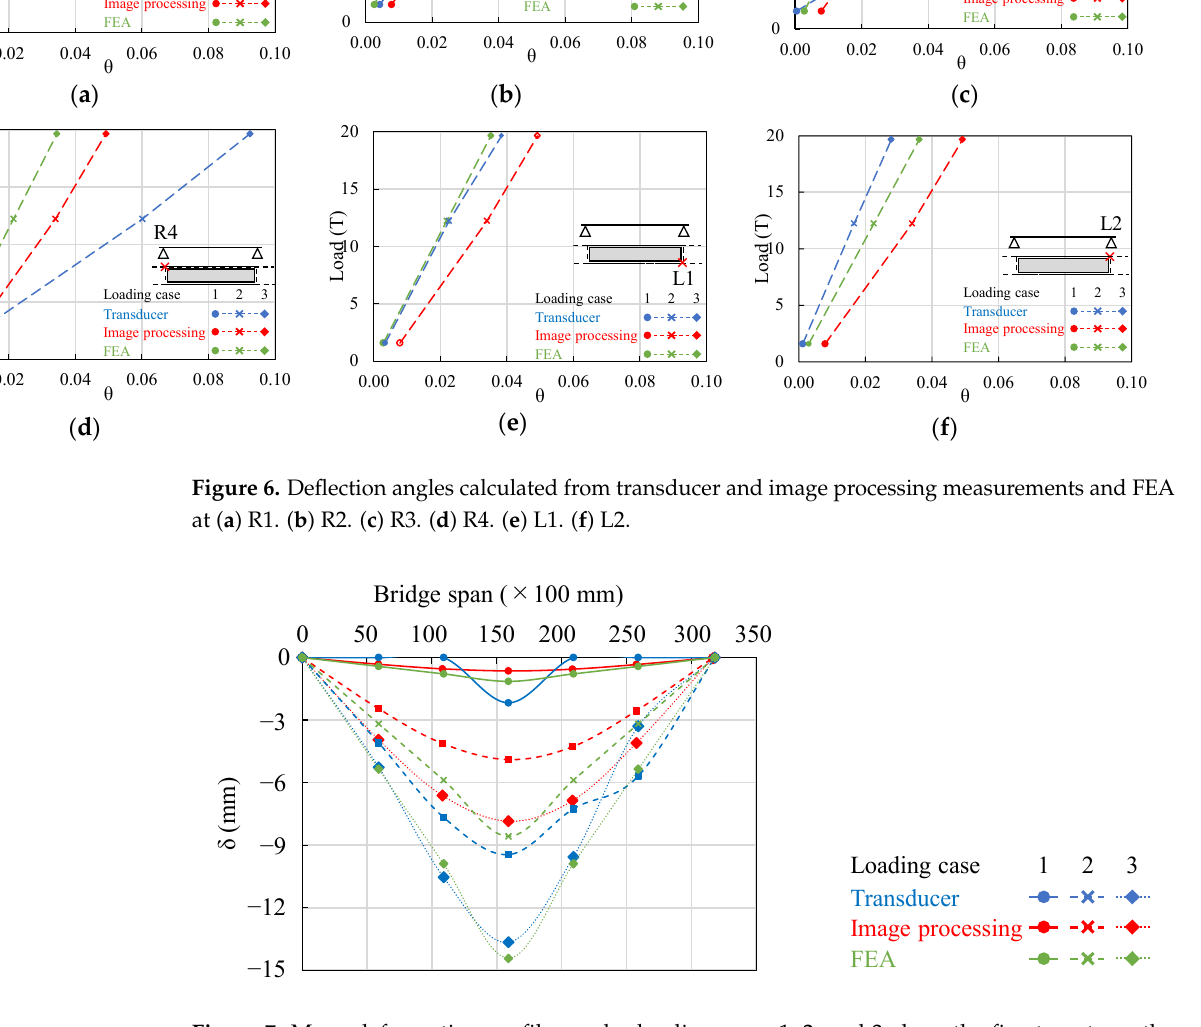
Figure 6. Deflection angles calculated from transducer and image processing measurements and FEA at ( a ) R1. ( b ) R2. ( c ) R3. ( d ) R4. ( e ) L1. ( f ) L2.